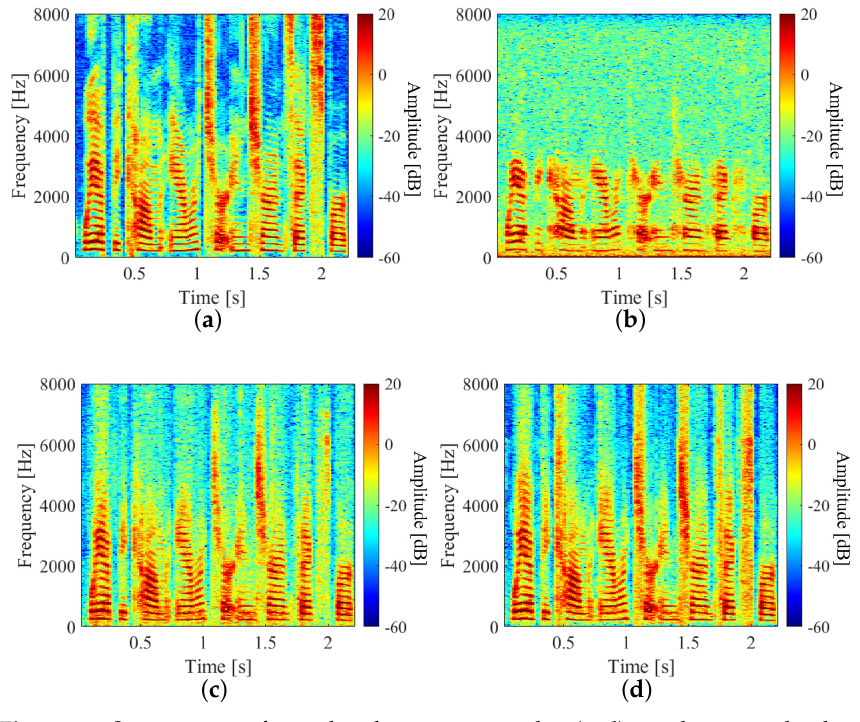
Figure 13. Spectrogram of speech-enhancement results: ( a – d ) are clean speech, observed speech, speech obtained by only noise suppression, speech enhanced with proposed waveform-based method